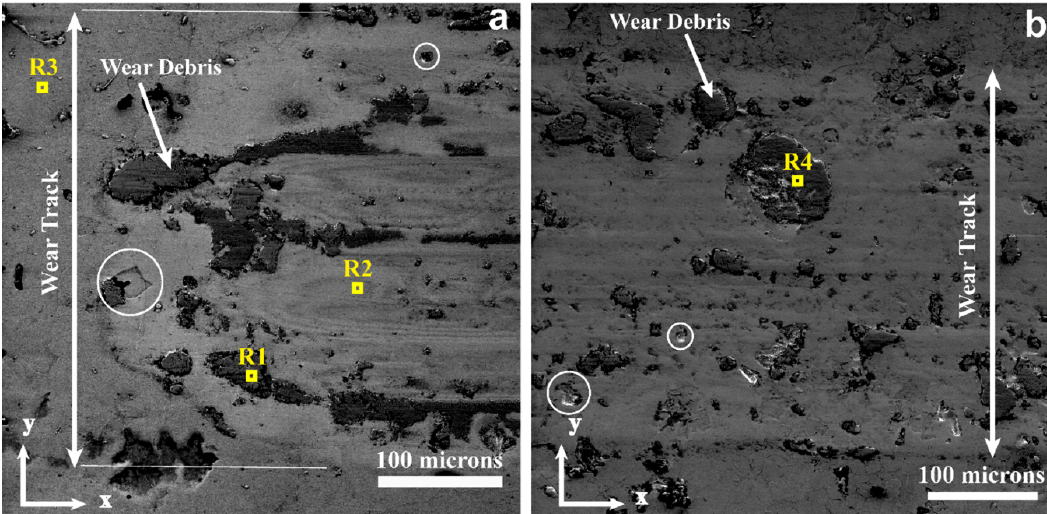
Figure 9. FE-SEM images of the wear track generated from the macro-tribology tests of the Hier-TaN / Ta coating, the white circles and yellow squares indicate limited cracking and points where the Raman spectra were obtained respectively; ( a ) left border; and ( b ) center of the wear track after the macro-tribology test.